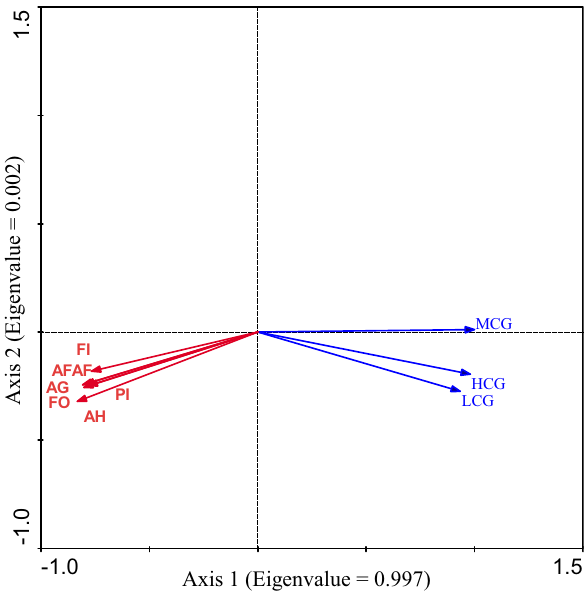
Figure 5. The correlation between the grassland coverage area and composite of gross agricultural output. HCG = High-coverage grassland area, MCG = Medium-coverage grassland area, LCG = Low-coverage grassland area, AFAF = Gross output value of agriculture and forestry, animal husbandry and fishery, AG = Agriculture output, PI = Plantingindustry output, FO = Forestry productionoutput, AH = Animal husbandryoutput, FI =